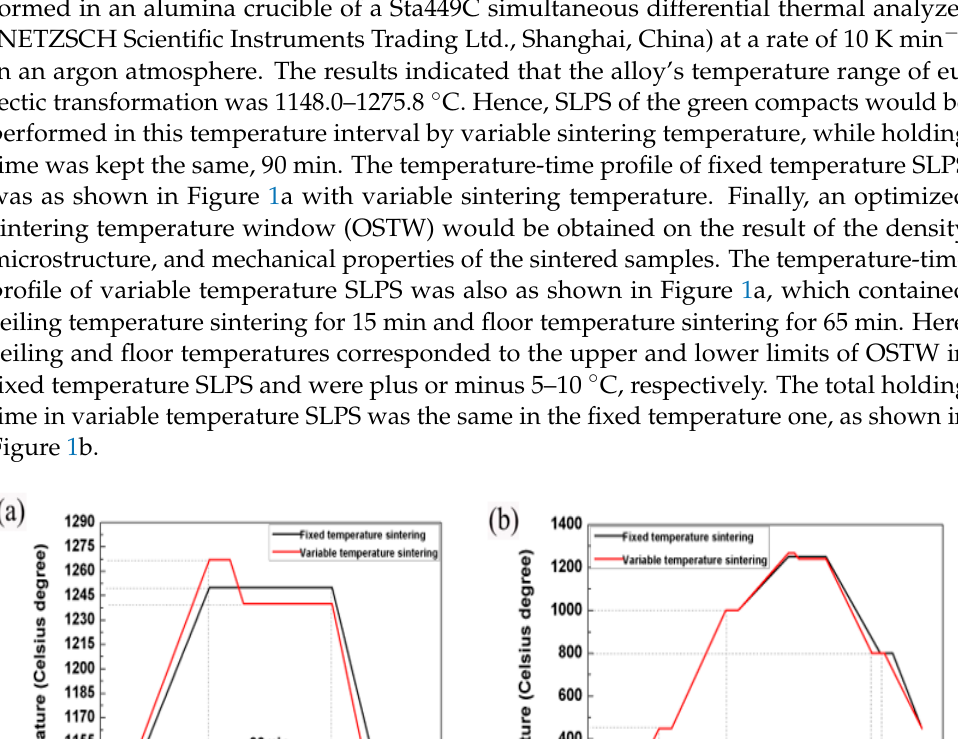
Table 2. The size distribution of the raw powders.